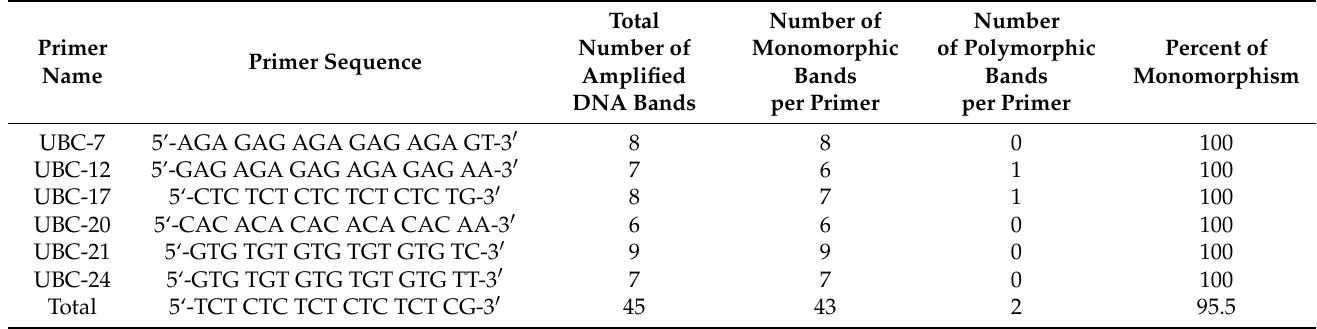
Table 2. List of primers and their sequences of the amplified fragments generated by ISSR markers for DNA fingerprinting of in vitro M. oblongifolia plants under AgNPs